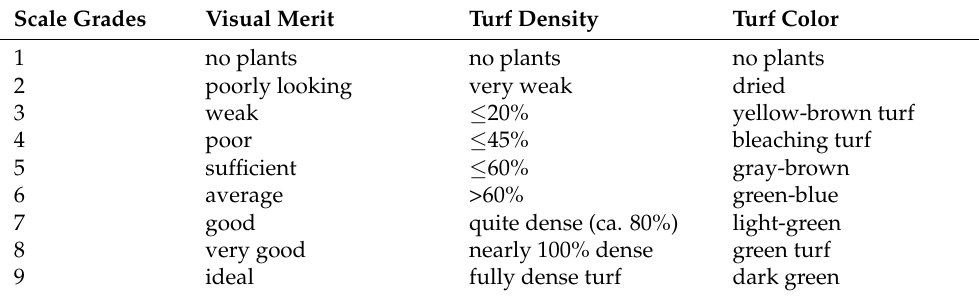
Table 2. Description of scale grades used for visual evaluation of lawn